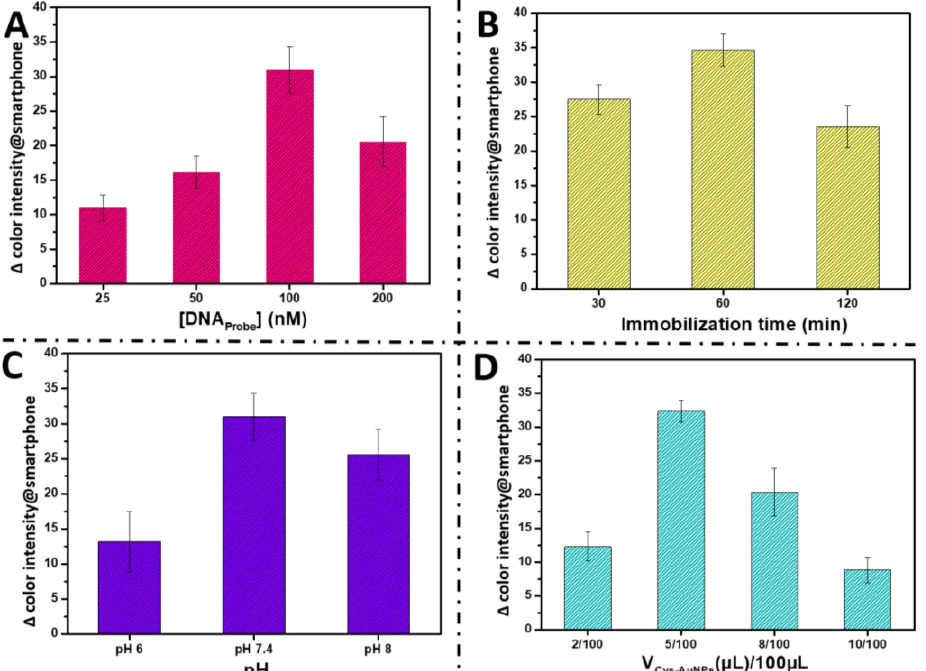
Figure 3. Optimization of factors impacting the paper-based miRNA-21 detection ( A ) DNA probe concentration immobilized on paper disk, ( B ) immobilization time of DNA probe , ( C ) pH of immobilization step, and ( D ) dilution of prepared Cys/AuNPs nanozyme. The response of the paper-based genosensor developed before and after hybridization with 100 pM of miRNA-21. Three parallel experiments yielded error bars.